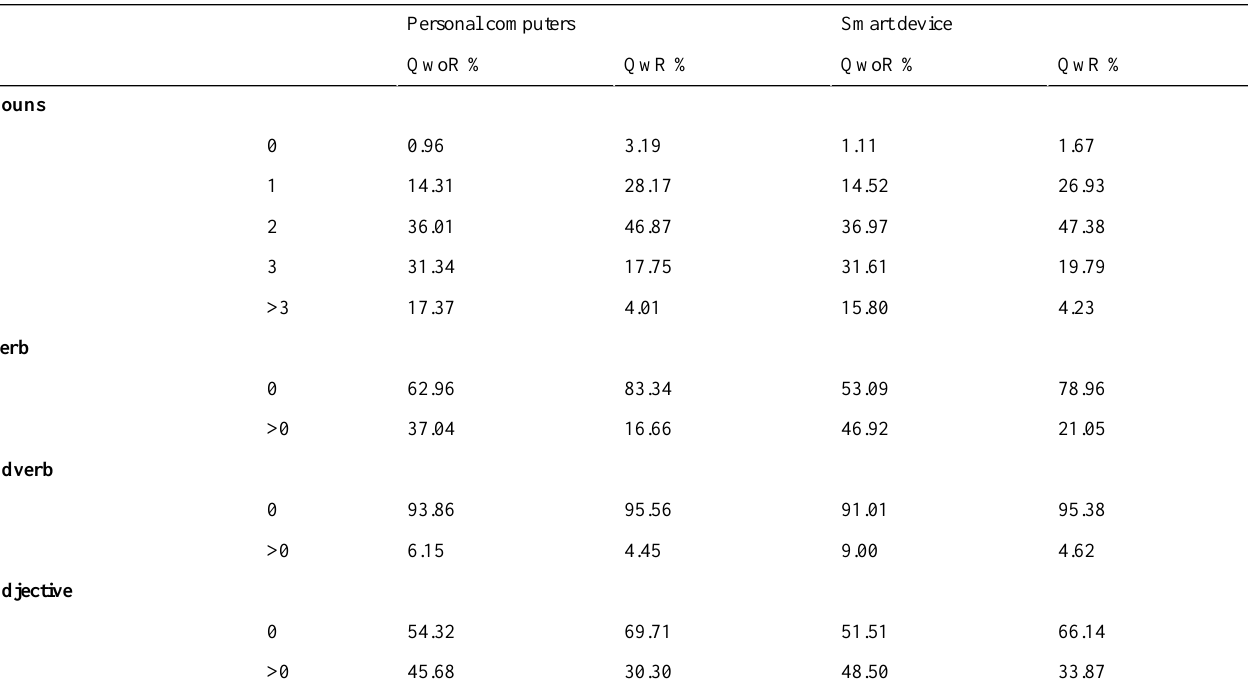
Table 3. Linguistic analysis of health search queries (June 2011-May 2013).